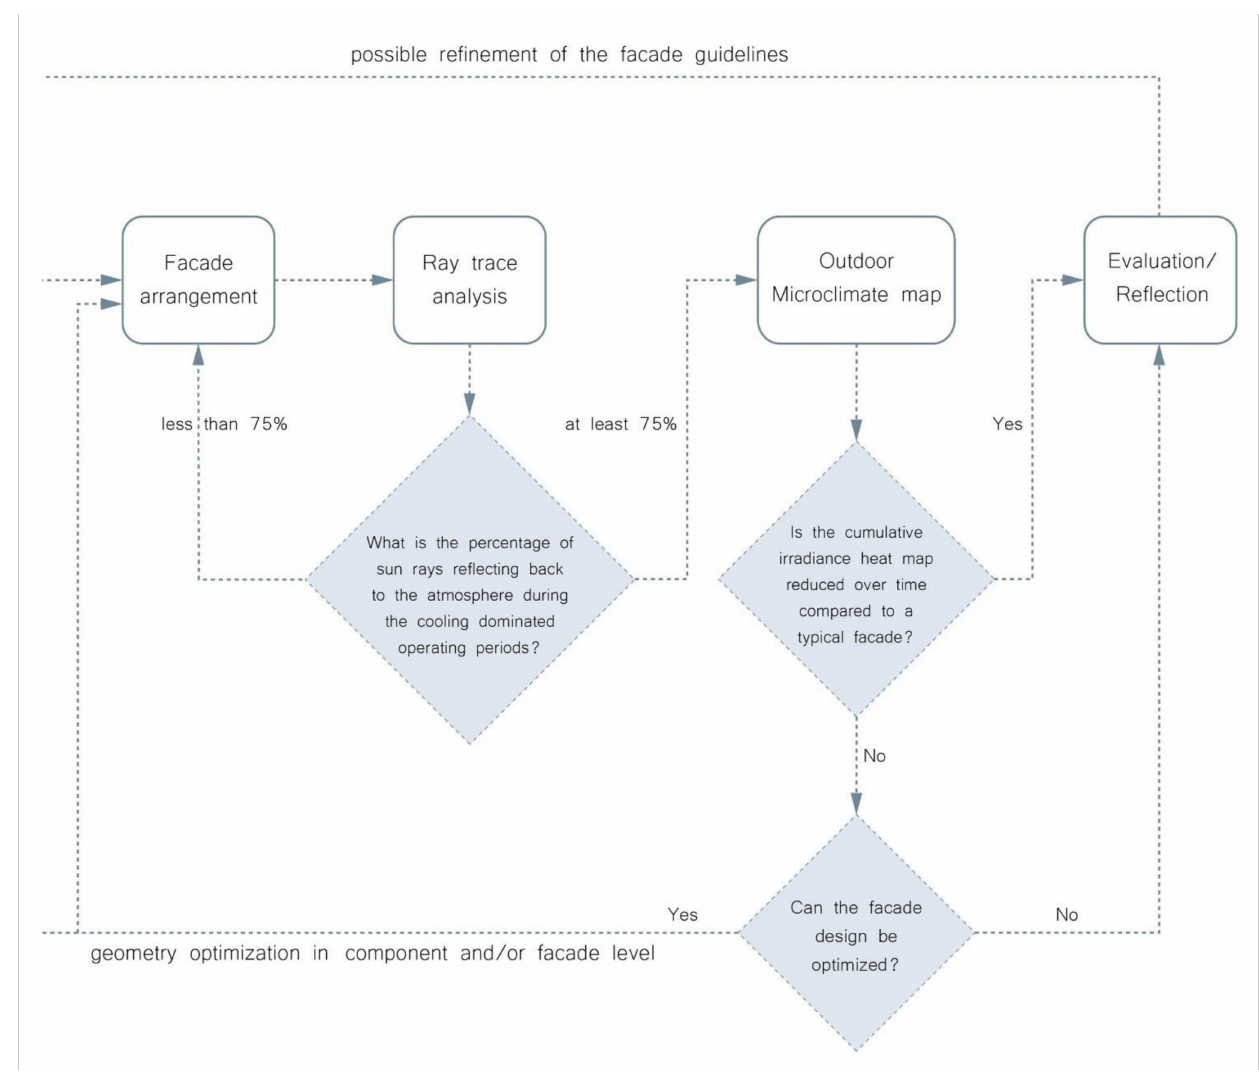
Figure 2. Flowchart of the feedback-loop iterative process of the UHI’s direct evaluation